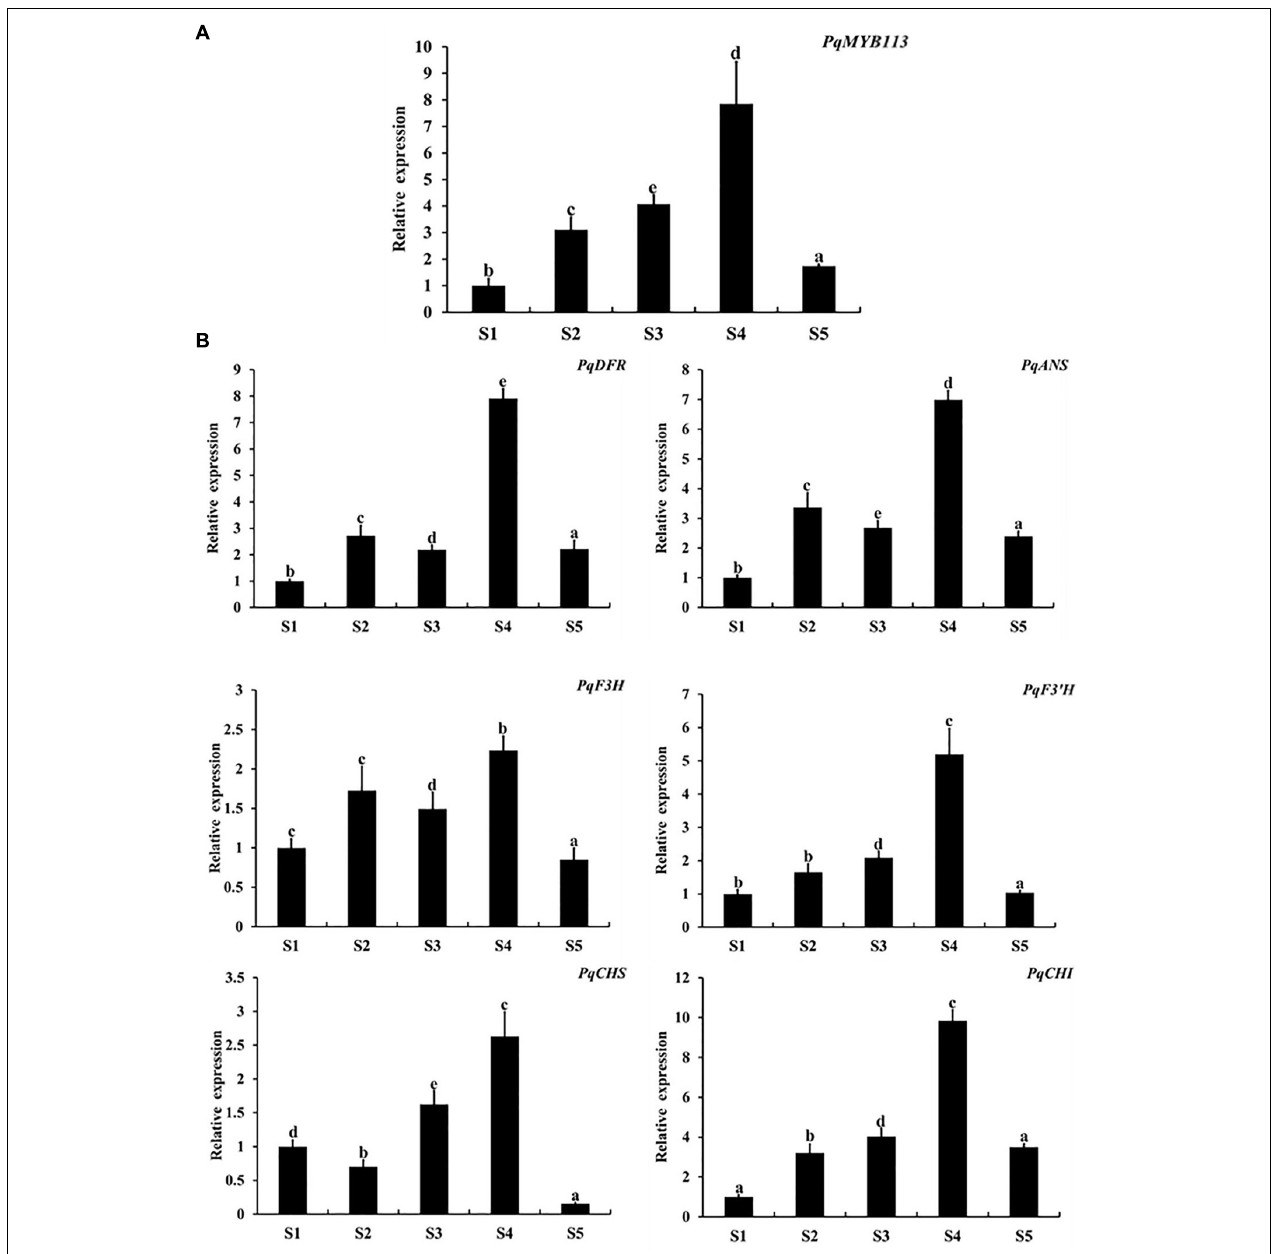
FIGURE 3 | Expression level of anthocyanin structural genes and MYB113 at different stages in P. qiui. (A) The expression level of PqMYB113 at different stages. (B) The expression level of anthocyanin structural genes at different stages. S1, leaves of 10 days after sprouting; S2, leaves of 20 days after sprouting; S3, leaves of 30 days after sprouting; S4, leaves of 40 days after sprouting; S5, leaves of 50 days after sprouting. Ubiquitin was used as an internal control. Error bars represent the standard errors. a, b, c, d, and e indicate significant differences at the p ≤ 0.05 level by Duncan’s